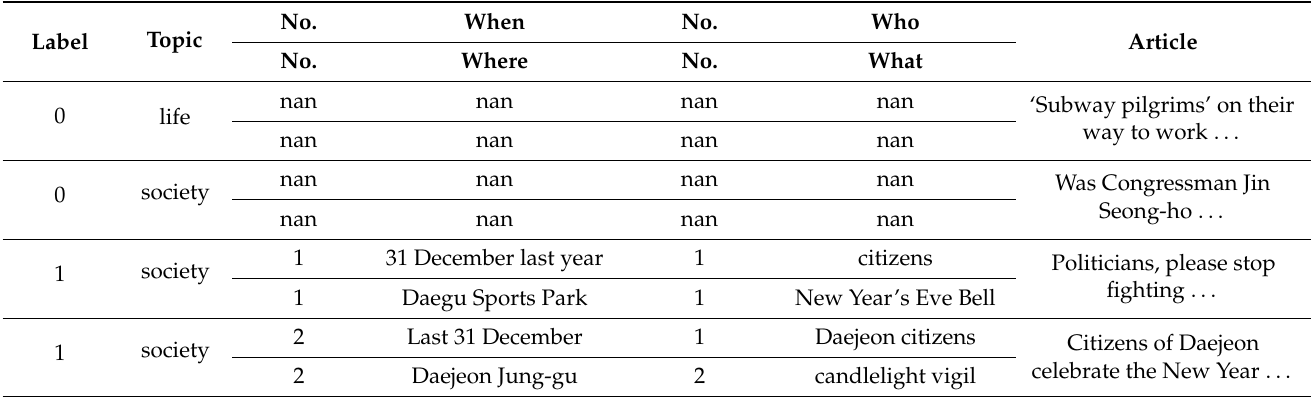
Table 1. Example of training data.